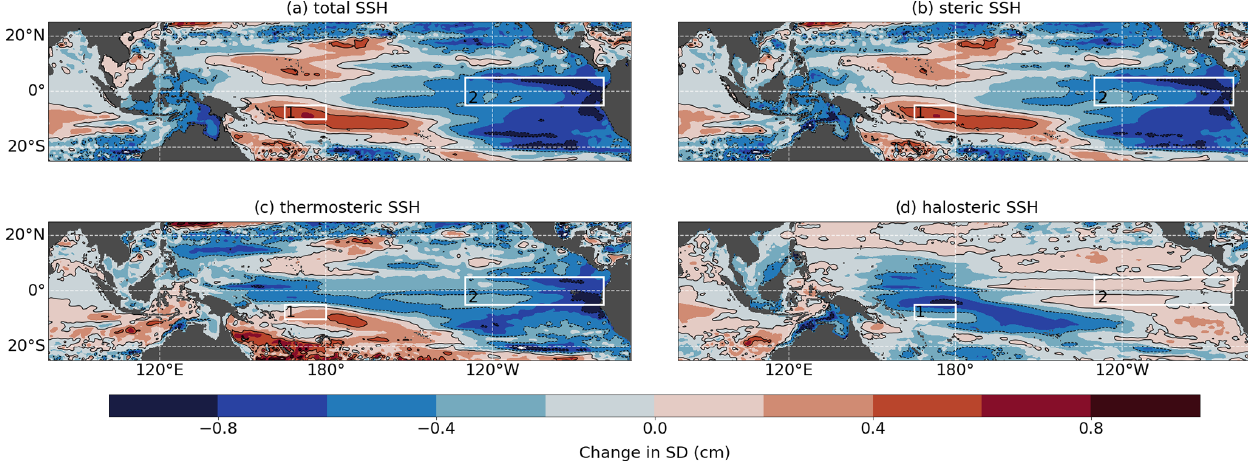
Figure 4. SD from O025-HC minus SD from O025-W90 for (a) total SSH, (b) steric SSH, (c) thermosteric SSH and (d) halosteric SSH. SD is based on the period from 1958 to 2016. The global mean trends have been subtracted, and all data were smoothed with a 12-month running-mean window prior to calculation. Contour lines mark ± 4, ± 8 and 0cm.